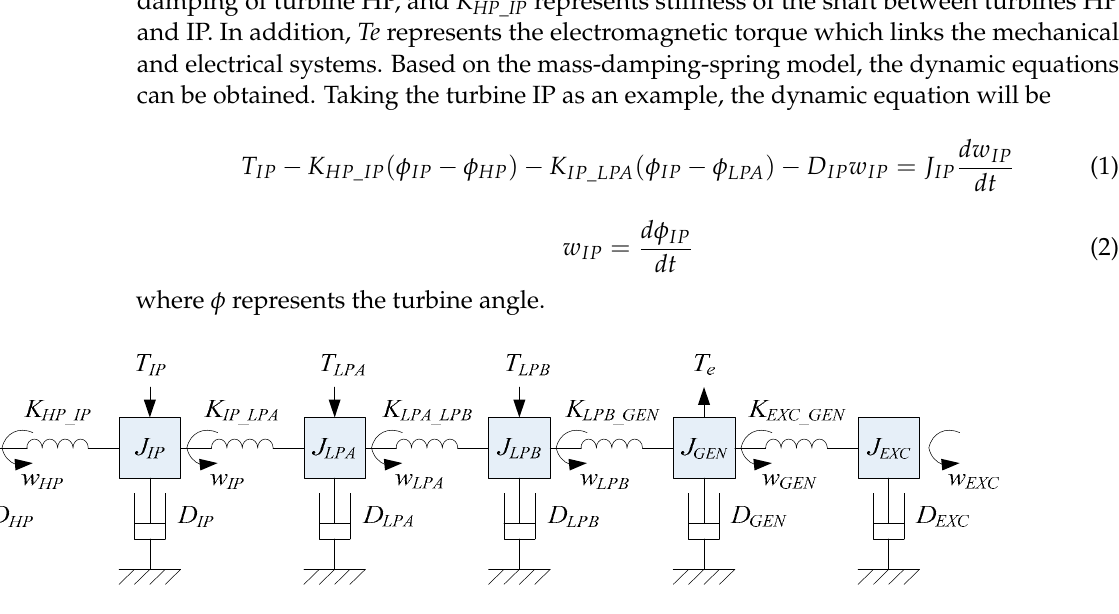
Figure 2. Lumped mass-damping-spring model of the turbine-and-generator mechanism. Table 1. Parameters of the mass-damping-spring model.